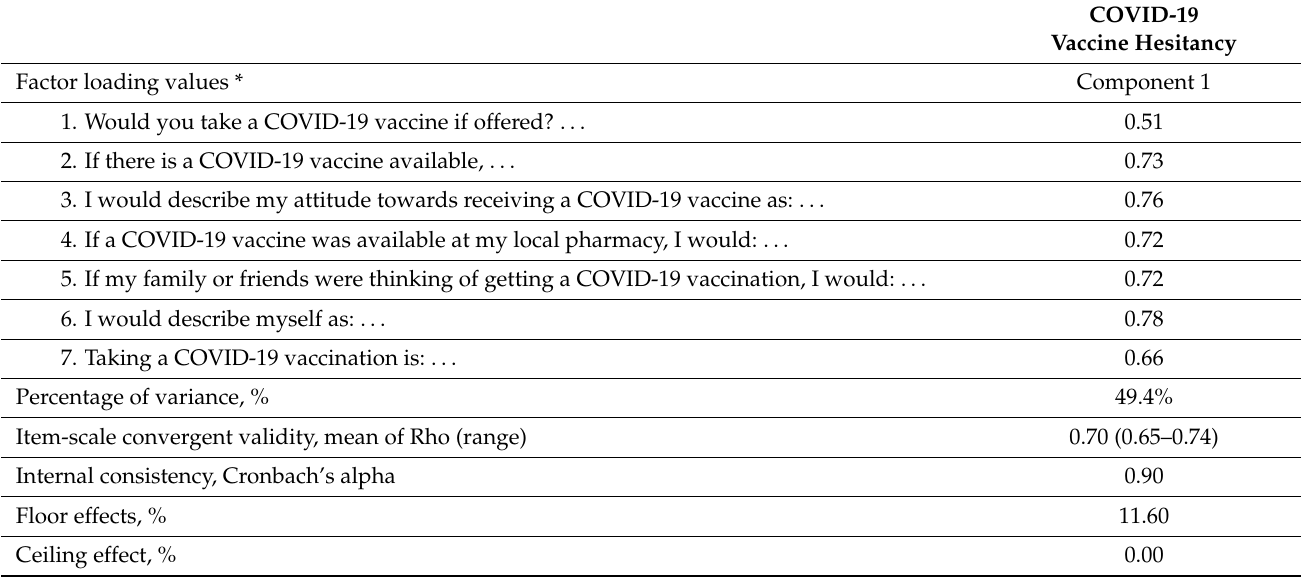
Table 3. Construct, convergent, internal consistency, floor and ceiling effects of COVID-19 vaccine hesitancy ( n = 387).